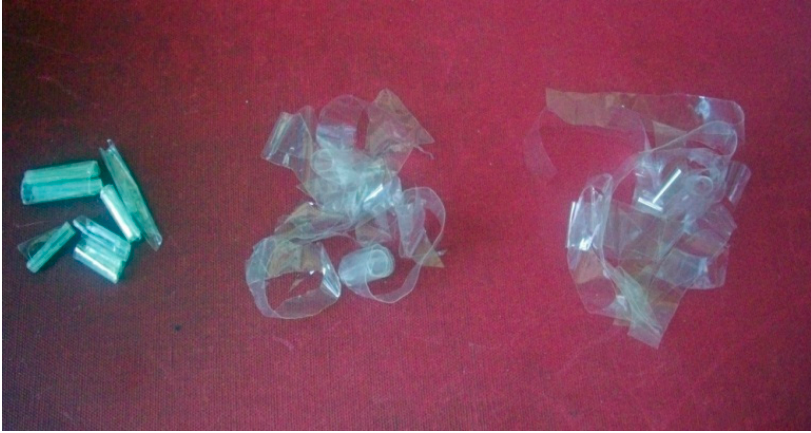
Figure 4. PE/Whey/PET films after treatment with 4% Terg-a-zyme for 1, 2, and 4 h.